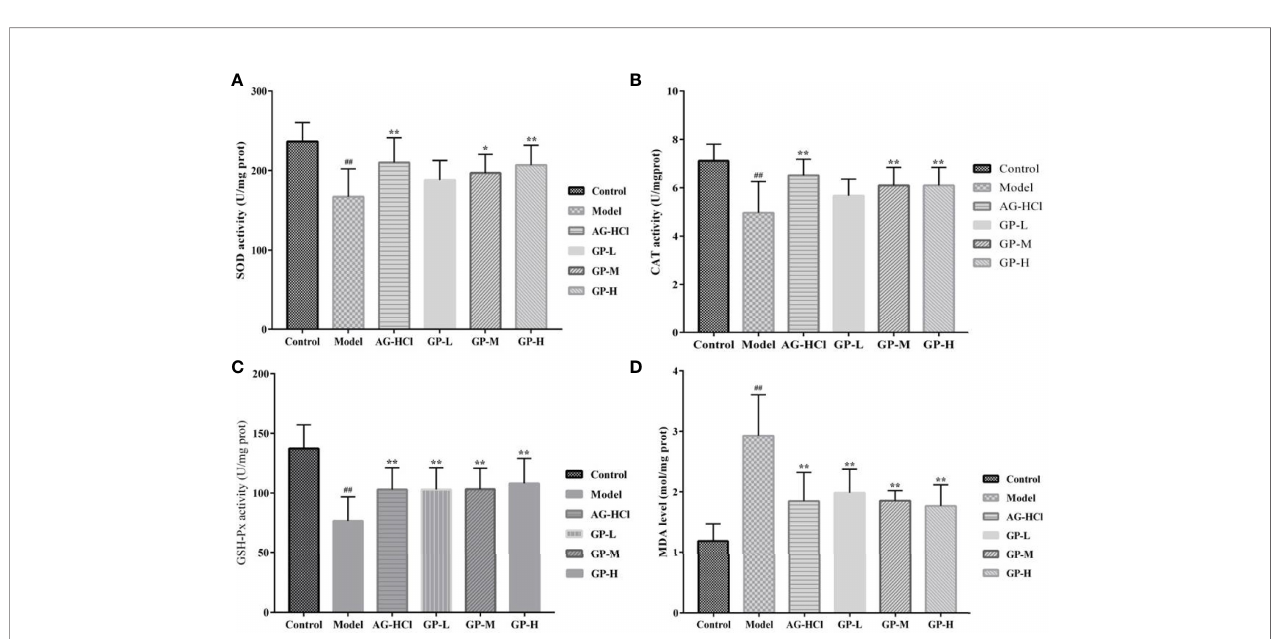
FIGURE 4 | Effects of GP on SOD (A) , GSH-Px (B) , CAT (C) , and MDA (D) in brain of mice (*p < 0.05, **p < 0.01 vs Model group; ##p < 0.01 vs Control